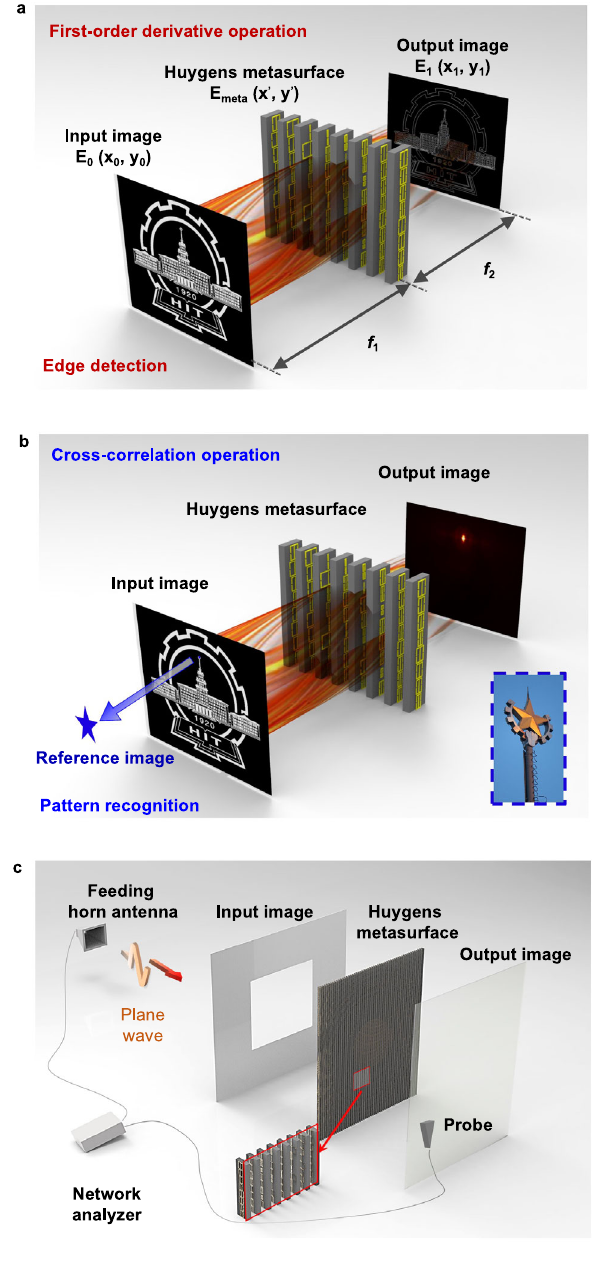
Fig. 2 Schematic diagram of analog computational system utilizing single-layer Huygens ’ metasurface. a Derivative operation and b cross- correlation operation performed on the input image. The inset shows the photograph of the star in the badge of HIT, which is de fi ned as the reference image here. c The experiment set-up with a zoomed-in view of the fabricated Huygens ’ metasurface (see Supplementary Note 9 for photographs of the fabricated Huygens ’ Fourier optical devices and shows high fl exibility compared to the GF approach (Fig. 1d).